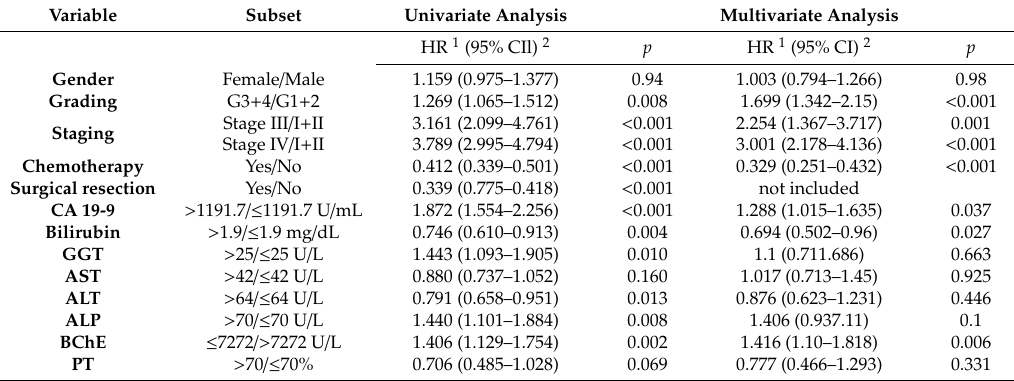
Table 2. Univariate and multivariate Cox proportional analysis regarding CSS in pancreatic cancer